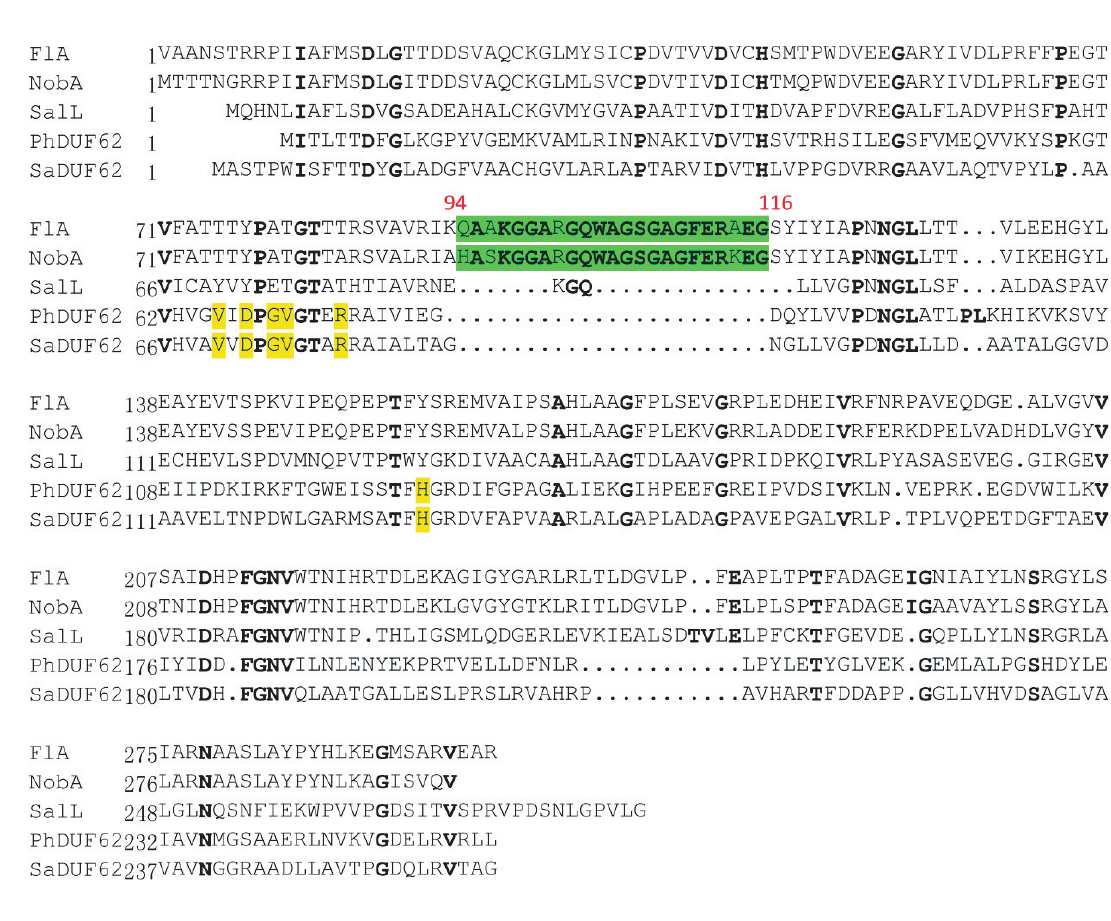
Figure S1. SAM-dependent haloginases and hydrolases of the DUF62 family. The residues highlighted in yellow are critical for SAM hydrolysis. The unique loops of fluorinase are highlighted in bright green. Accession numbers for DUF62 proteins are SalL from Salinispora tropica (ABP73643), PhDUF62 from Pyrococcus horikoshii OT3 (NP_142440) and SaDUF62 from S. arenicola CNS-205